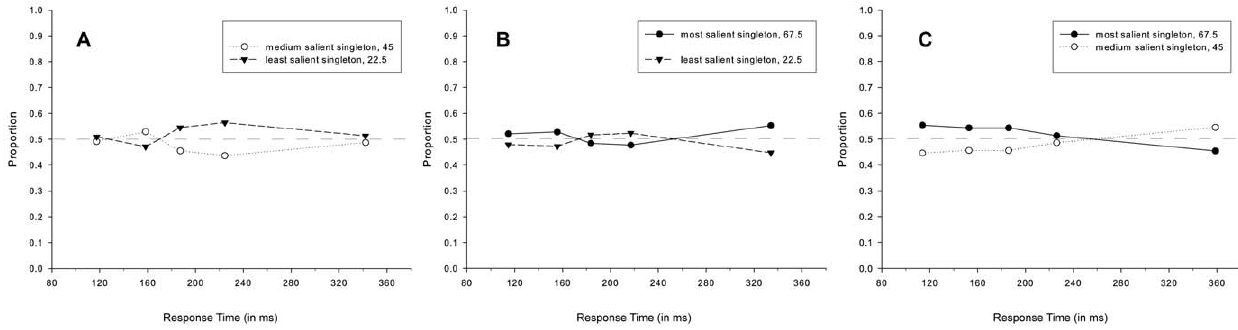
Figure 5. Salience-driven selection in second saccades in Experiment 2. Proportions of second saccades directed toward either of the two remaining singletons, separately for each bin of the response time distribution and irrespective of target identity, given that the initial saccade landed on A) the most, B) the medium, or C) the least salient singleton.